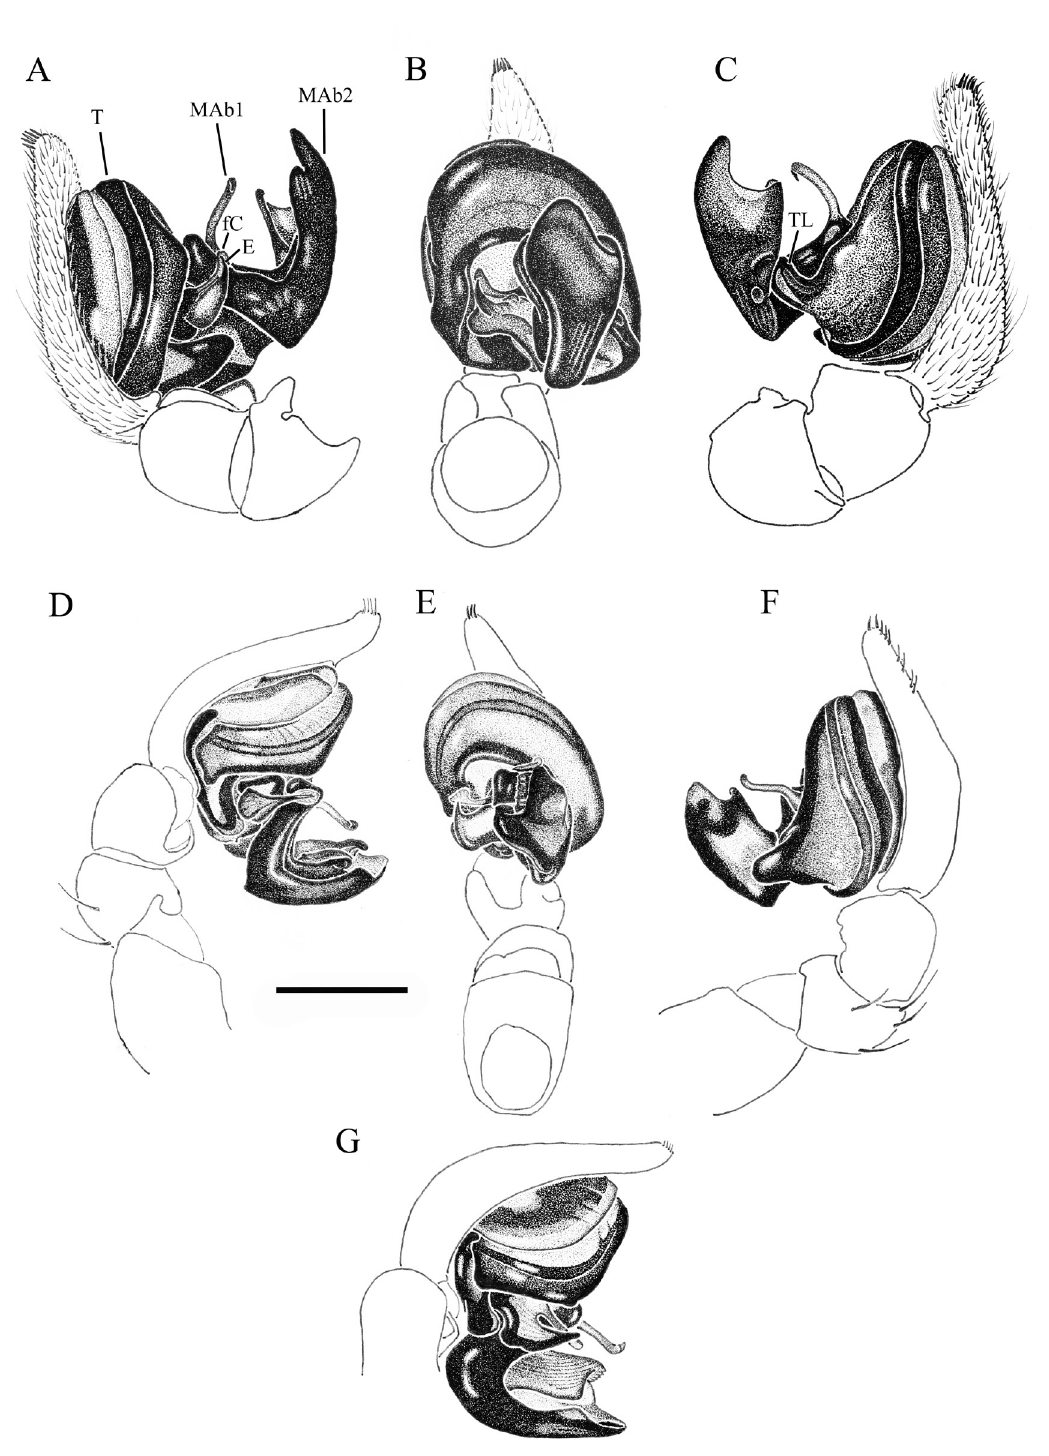
Fig. 7. Left male palps. A – C . Uroctea grossa Roewer, 1960, ♂ from Sistan and Baluchistan Province, surroundings of Taftan volcano (MHNG). D – F . Uroctea gambronica sp. nov., holotype, ♂ (NMP- P6j-180/2002). G . Uroctea thaleri Rheims, Santos & van Harten, 2007, ♂ from Hormozgan Province, Minab County (MHNG). A, D, G = prolateral view; B, E = ventral view; C, F = retrolateral view. Scale bars = 1